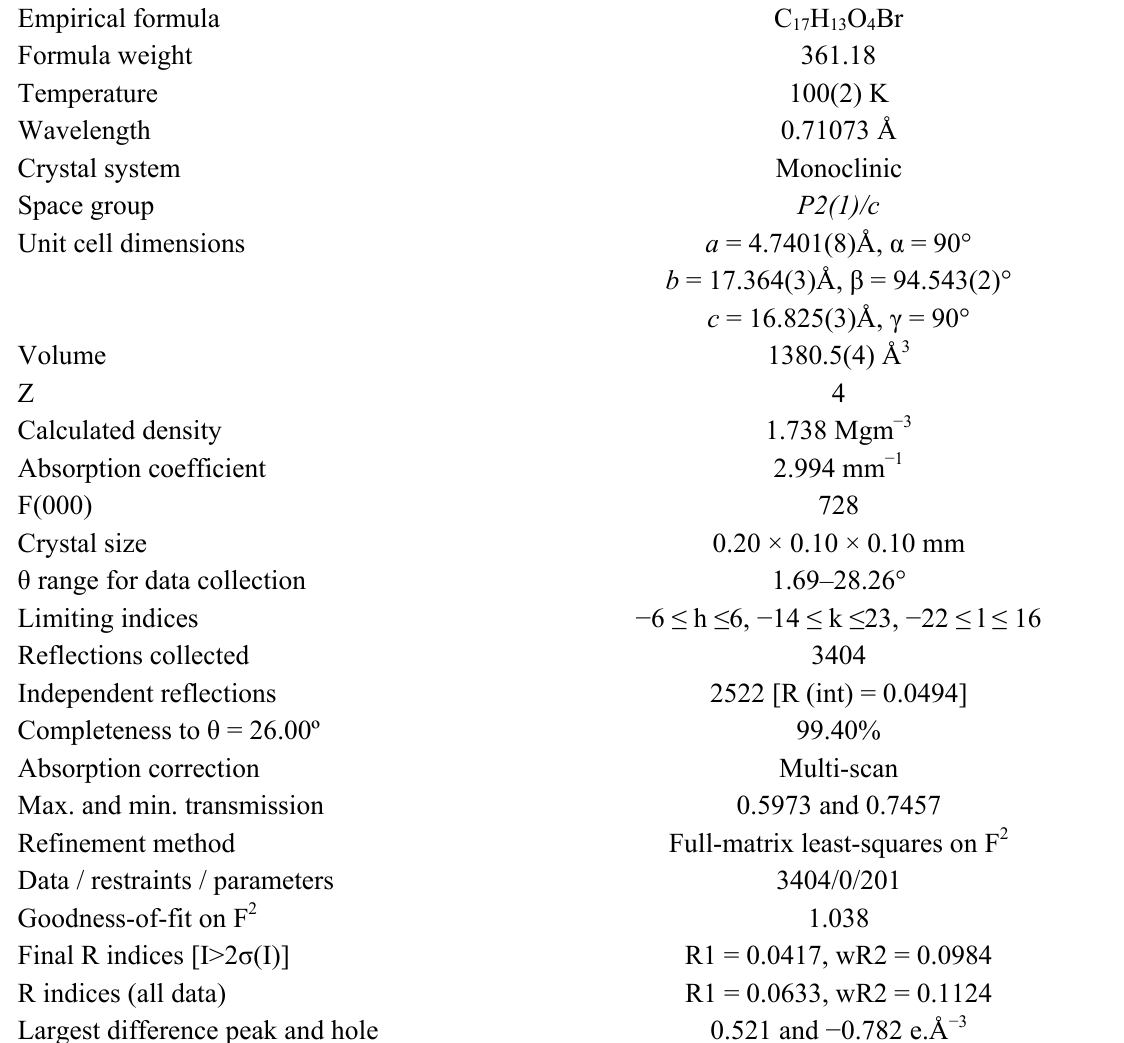
Table 2. Crystal data and structure refinement for 2-bromomethyl-1,3-dimethoxyanthraquinone ( 5